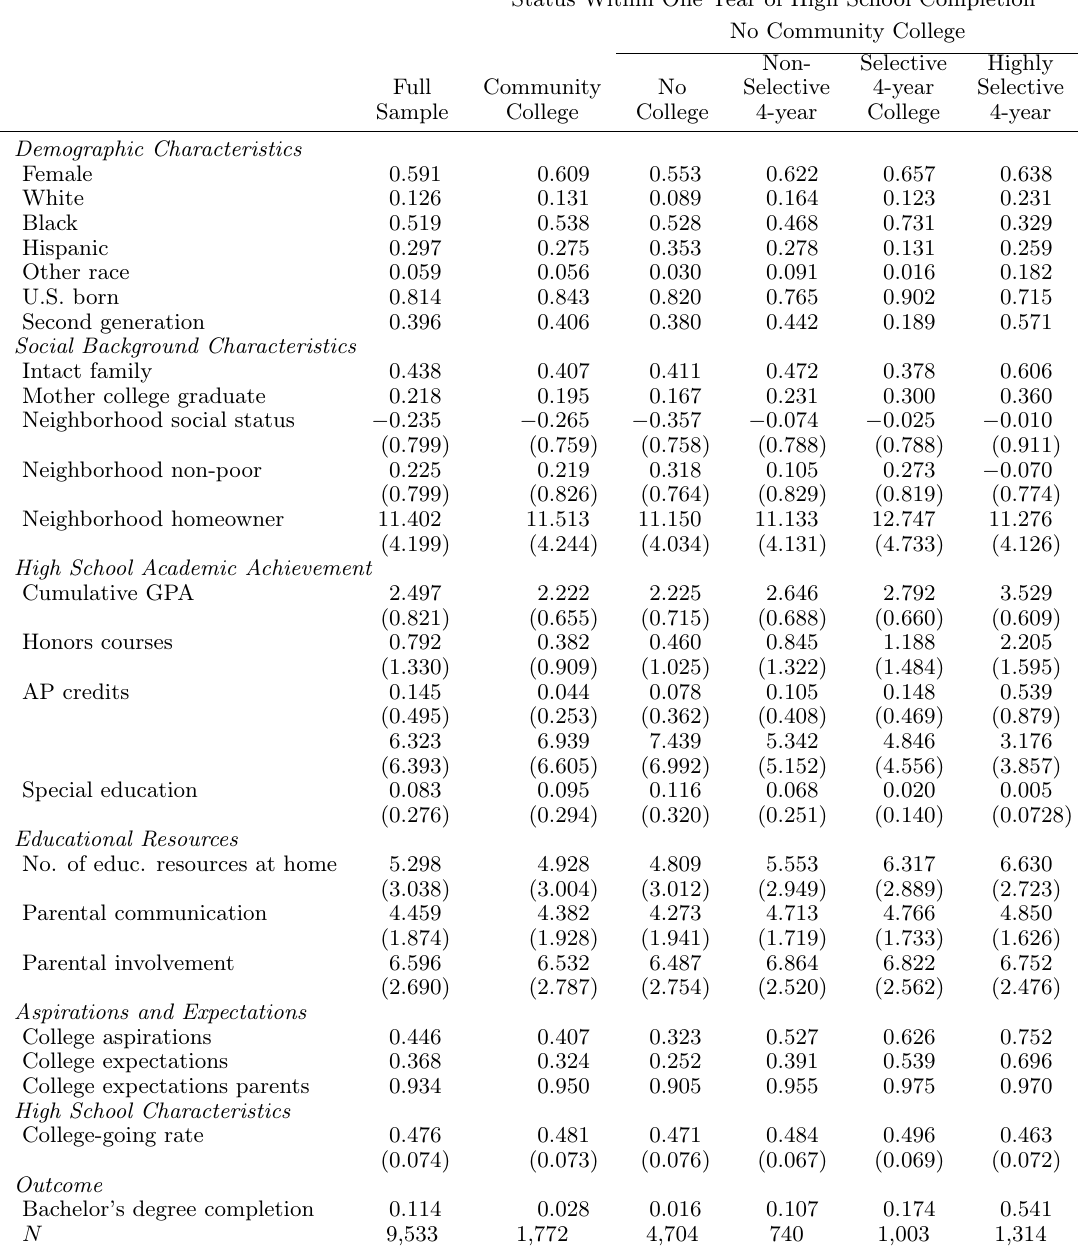
Table 1: Descriptive Statistics by Educational Path: Chicago Public Schools